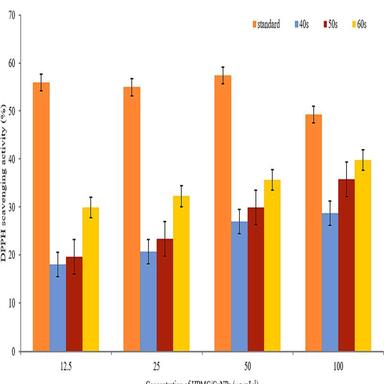
DPPH free radical scavenging of synthesized HPMC /copper nanobiocomposites.